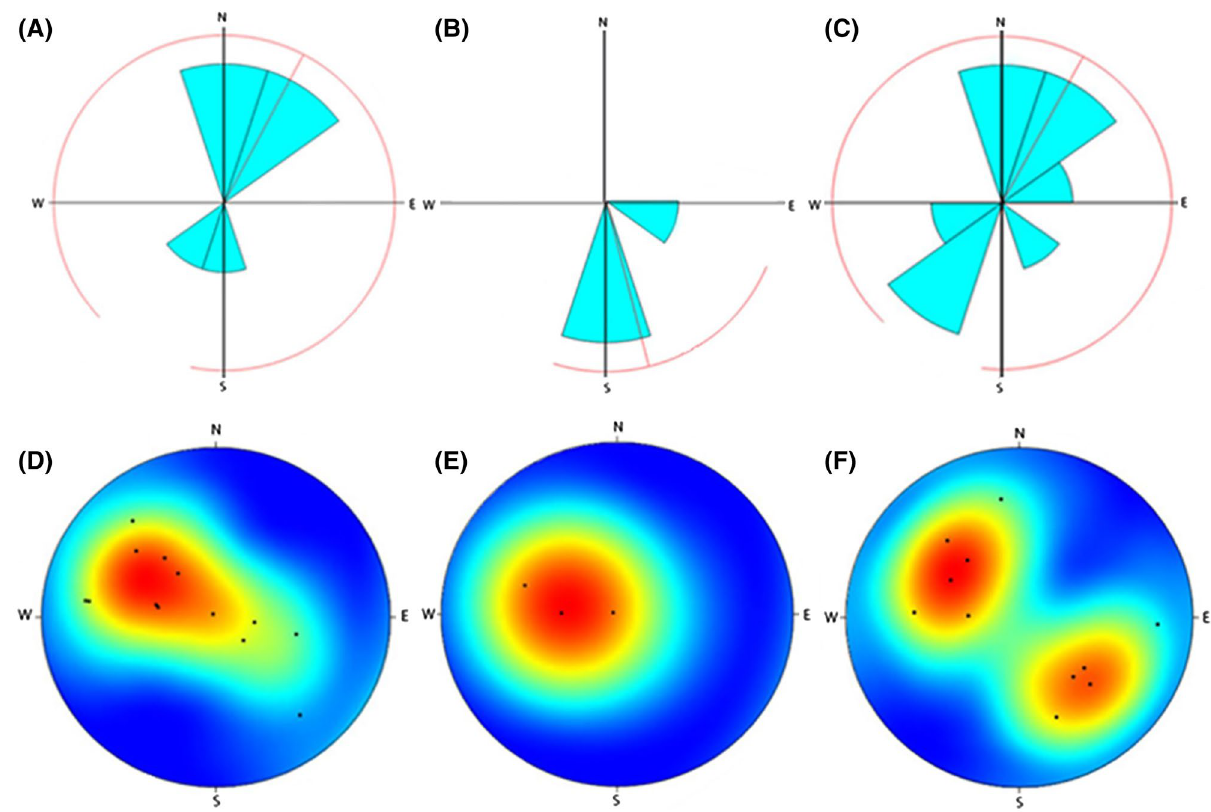
Figure 6. ( A – C ) Orientations of internal clasts of the discrete breccia subsamples in relation to the cave passage orientations from: ( A ) Lida Ajer cave (5 subsamples); ( B ) Ngalau Gupin cave (3 subsamples); ( C ) Ngalau Sampit cave (4 subsamples). Figures ( A – C ) are calculated using geometrical directions (one sample) function 36 . The red lines denote the mean angle. ( D – F ) Stereoplots of the slope and slope direction of the internal clasts of the breccia subsamples in relation to the cave passage orientations and slopes from: ( D ) Lida Ajer cave; ( E ) Ngalau Gupin cave; ( F ) Ngalau Sampit cave. Figures ( D – F ) are calculated using a spherical function 36 . Colour warmth maps the commonality of clasts sloping in one direction, with blue denoting no or few clasts to red denoting the greatest number of